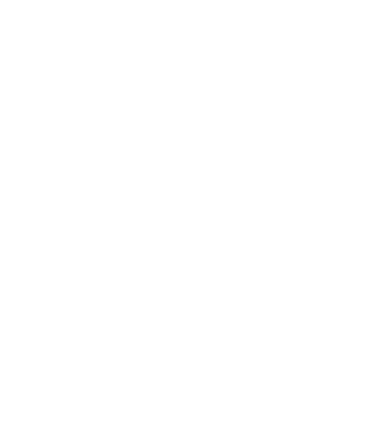
FIGURE 2 | Targeting of mTOR protein to ROS-dependent proteasome degradation. (A) Inhibition of mTOR signaling by carnosol in MDA-MB-231 cells. Cells were treated for 24 hours with carnosol (50 and 100 m M) and whole protein lysates were analyzed by Western blot for phosphorylated and total mTOR protein. (B) Western blot analysis of mTOR protein level in MDA-MB-231 cells pre-treated with the autophagy inhibitors 3-MA and CQ. Cells were pretreated with or without 3-MA (50 mM) and CQ (50 m M) for 1 h before adding carnosol for 24 hours. (C) Carnosol targets mTOR to proteasome degradation. MDA-MB-231 cells were pre-treated for 1h with or without Bortezomib (25nM) before treatment with carnosol at the indicated concentrations for 24. Whole protein lysates were resolved on SDS-PAGE and analyzed for mTOR protein.